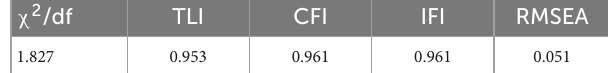
TABLE 3 Fit indices of confirmatory factor